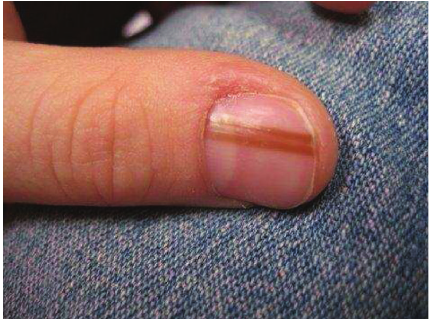
Figure 5: Nail apparatus nevus in a